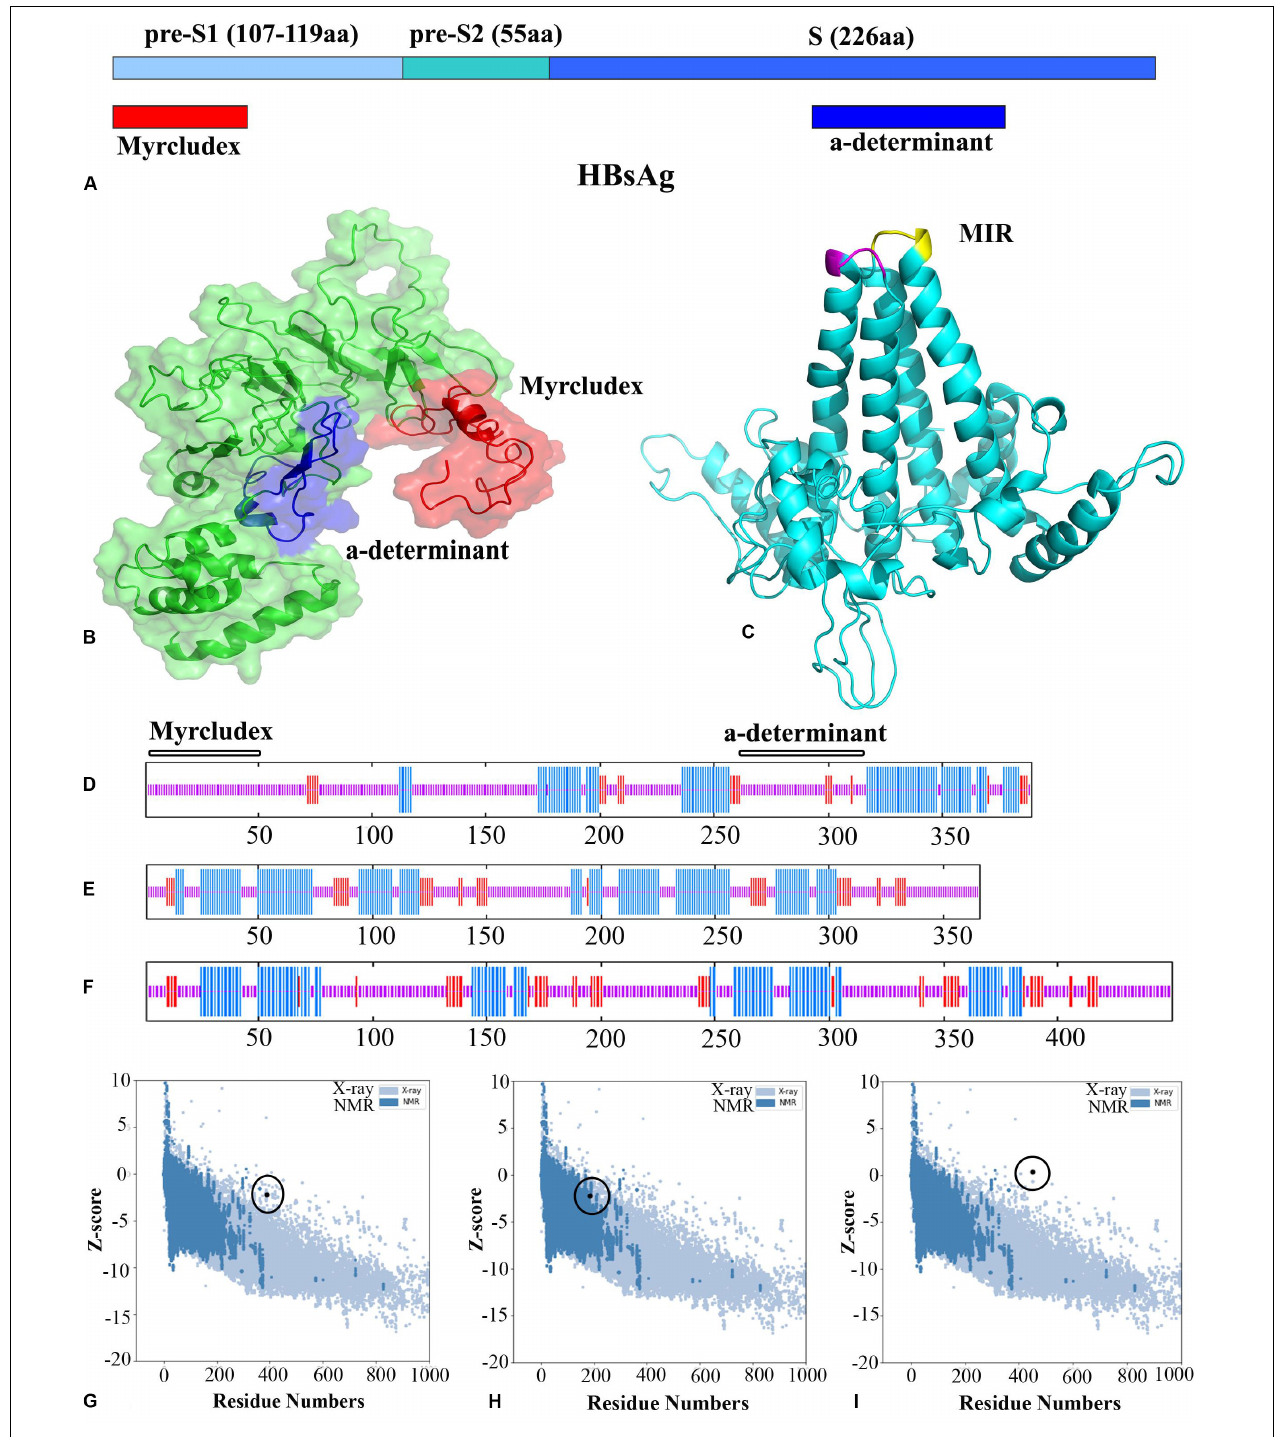
FIGURE 2 | Hepatitis B surface antigen (HBsAg) and hepatitis B core antigen (HBcAg) representations, the Z -score ProSA plots of the structures, and their cartoonic representation. (A) Schematic view of the S gene in HBV. (B) Three-dimensional (3D) structure of an HBsAg (residues 1–389). Myrcludex and the “a” determinant regions are shown in red and blue , respectively. (C) 3D structure of the HBcAg dimer (the MIR in monomers is shown in magenta and yellow ). (D–F) Secondary structure prediction of HBsAg, HBcAg dimer, and the designed virus-like particle (VLP)-based vaccine. The alpha helix, extended strand, and random coils are indicated in blue , red , and pink lines , respectively. (G–I) ProSA plots of HBsAg, HBcAg, and the VLP-based vaccine. Black spot represents the evaluation of the input structure within the range of experimentally determined structure for proteins of similar size.